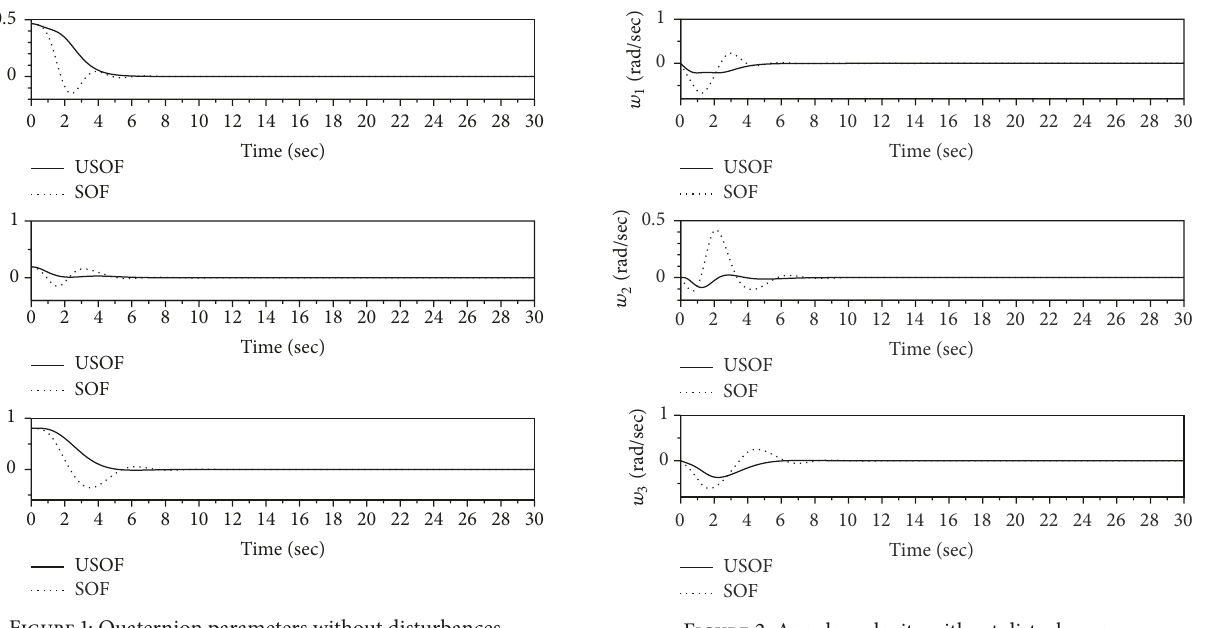
Figure 1: Quaternion parameters without disturbances. Figure 2: Angular velocity without disturbances.